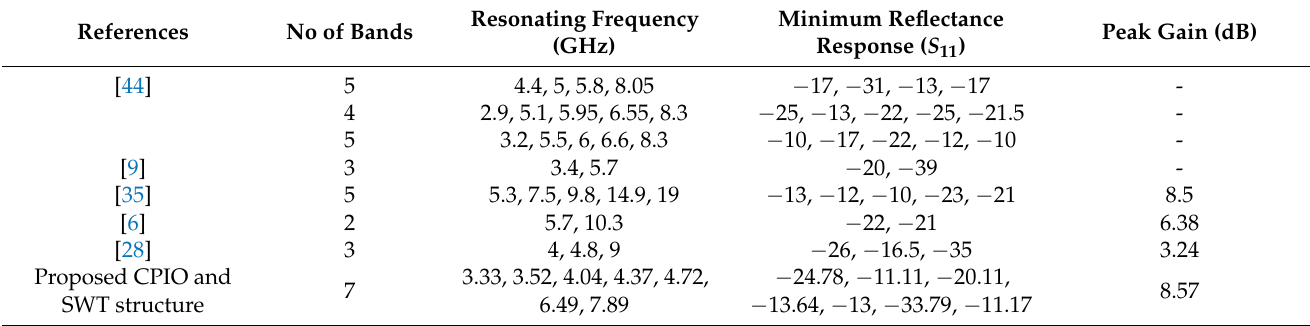
Table 5. Comparison of the proposed structure with another multiband